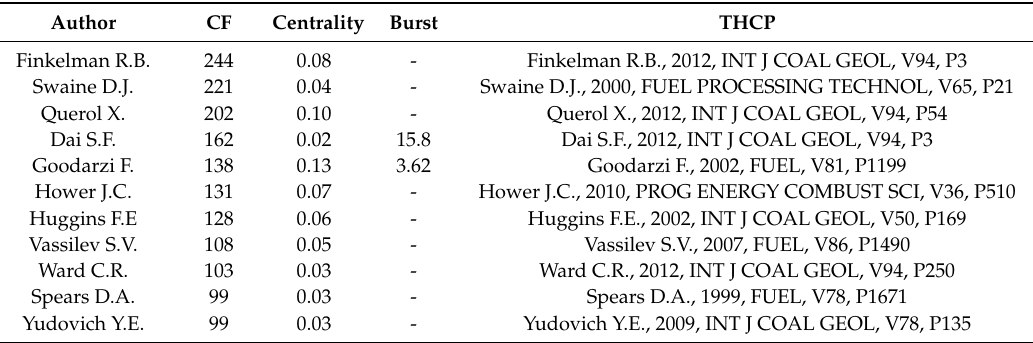
Table 2. Information of highly cited authors of trace elements in coal and